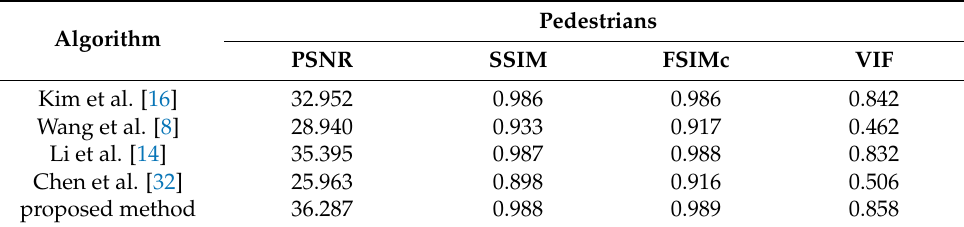
Table 1. Quantitative performance comparison of synthetic snow videos. All the results are the average of 200 frames.